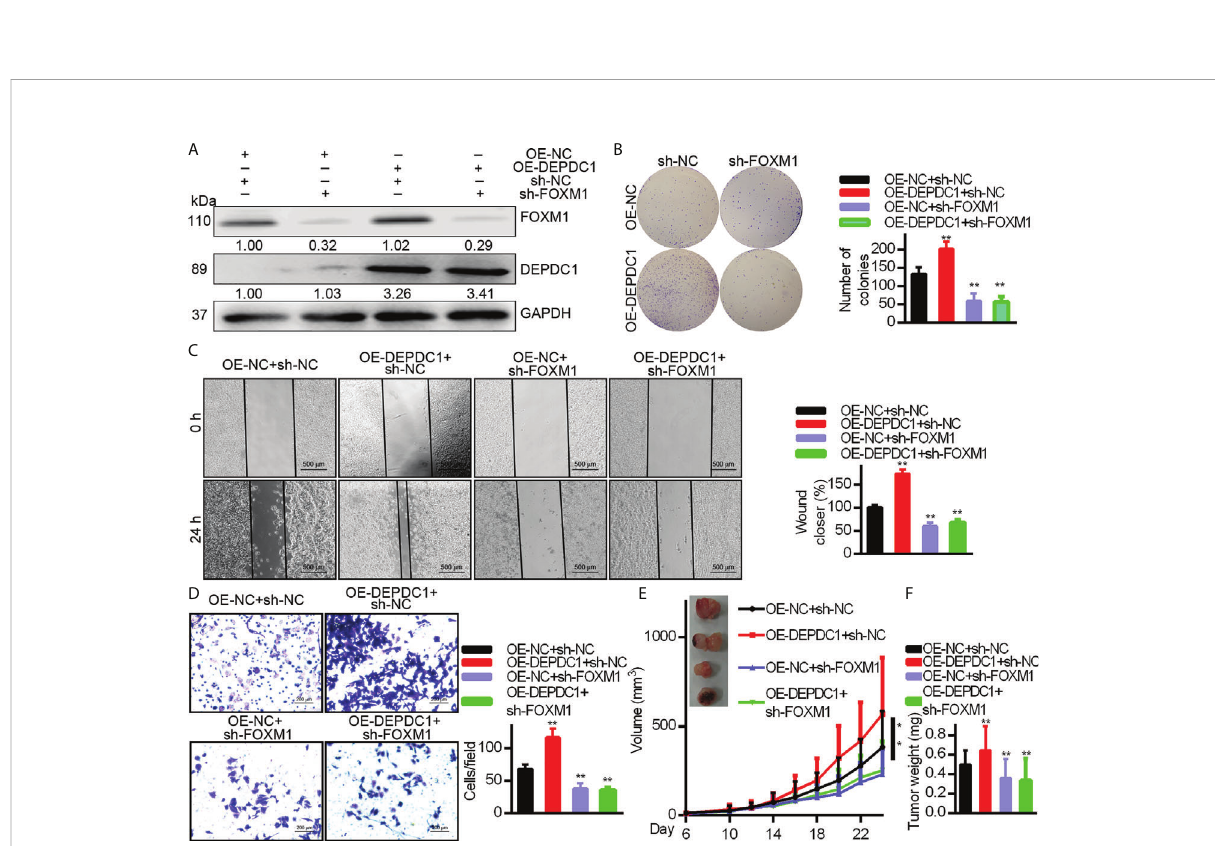
FIGURE 4 DEPDC1 facilitates the OSCC cell migration and growth via FOXM1. DEPDC1-over-expressing CAL-27 cells had FOXM1 knocked down. The indicated antibodies were used for Western blotting cell lysates (A) . Colony formation (B) , wound healing (500 m m scale bar) (C) , and Transwell (100 m m scale bar) assays (D) have been studied in cell growth and migration. The results shown for ( B – D ) are mean ± S.D. N = 3 separate tests. Data were analyzed with the student ’ s t-test . In the CAL-27 cells, FOXM1 was knocked down with high or low over-expression of DEPDC1 and 1.5 × 10 6 cells were injected under the skin of 6-week nude mice (n = 6). The development of tumours was studied. The data are shown as mean ± S.D. The student ’ s t-test (F) , Two-way ANOVA procedure (E) and been used to assess statistical signi fi cance. The data are representative of at least 3 independent experiments * P < 0.05, ** P <